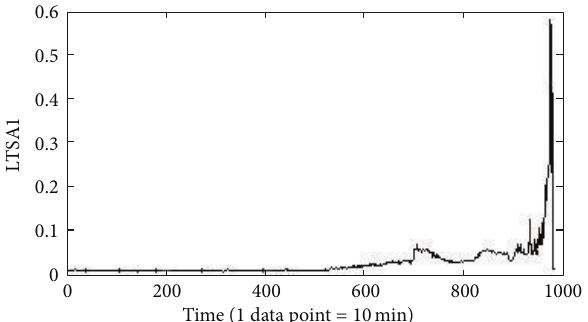
Figure 7: The first main projected vector of test bearing based on LTSA method.